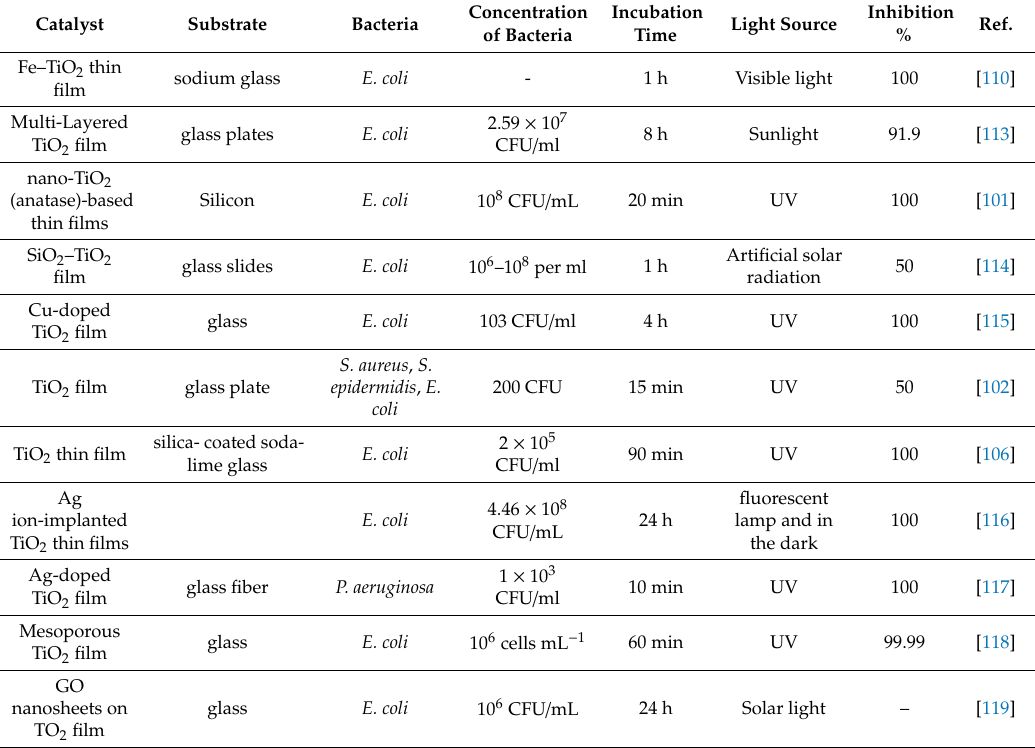
Table 3. Antibacterial performance of various TiO 2 films prepared by the sol-gel method.